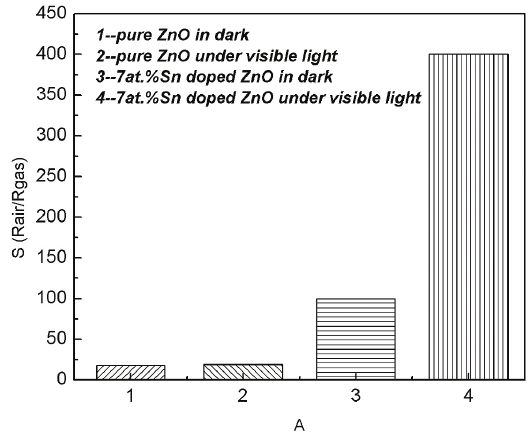
Figure 9. Sensitivity of different samples.